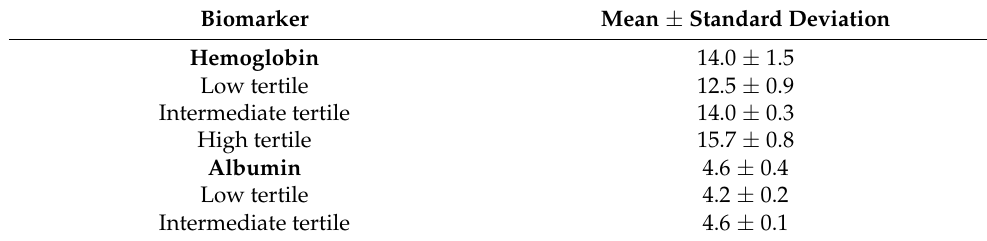
Table 2. Tertiles of the nutritional deficiency biomarkers in the study sample ( n = 255).